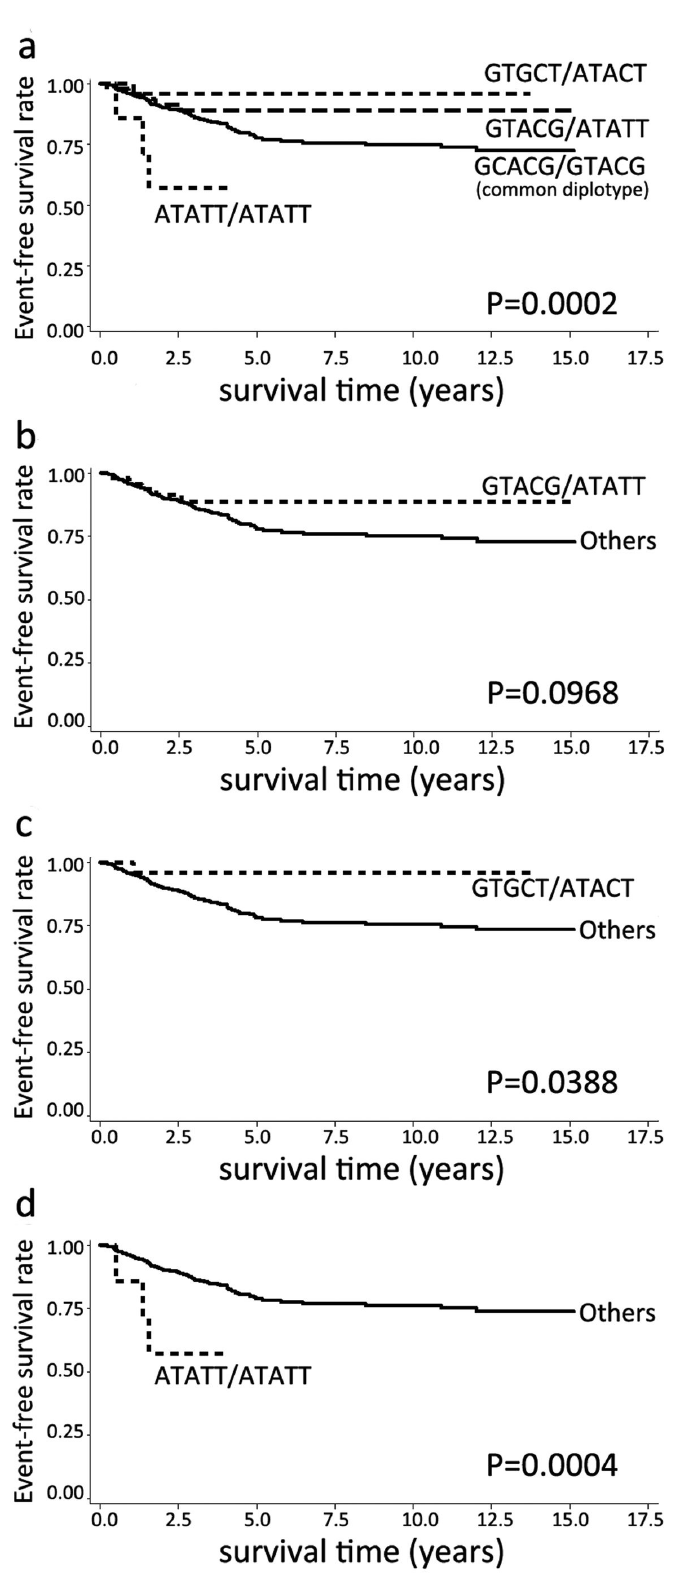
Figure 3. Kaplan-Meier estimates of event-free survival according to CDK1 diplotypes.